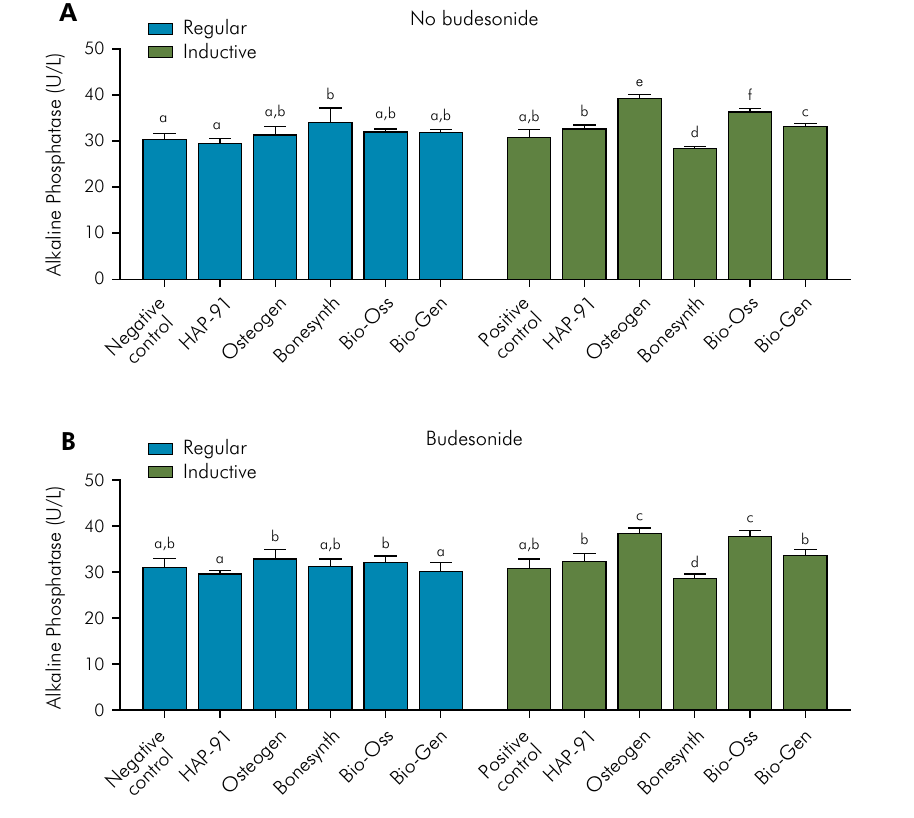
Figure 8. Bar graphs showing the results of the APA assay representing the mineralization potential of MC3T3-E1 cells cultured in media conditioned with each HA comparing the regular and inductive conditions, considering the absence (a) or addition of 0.5% v/v budesonide